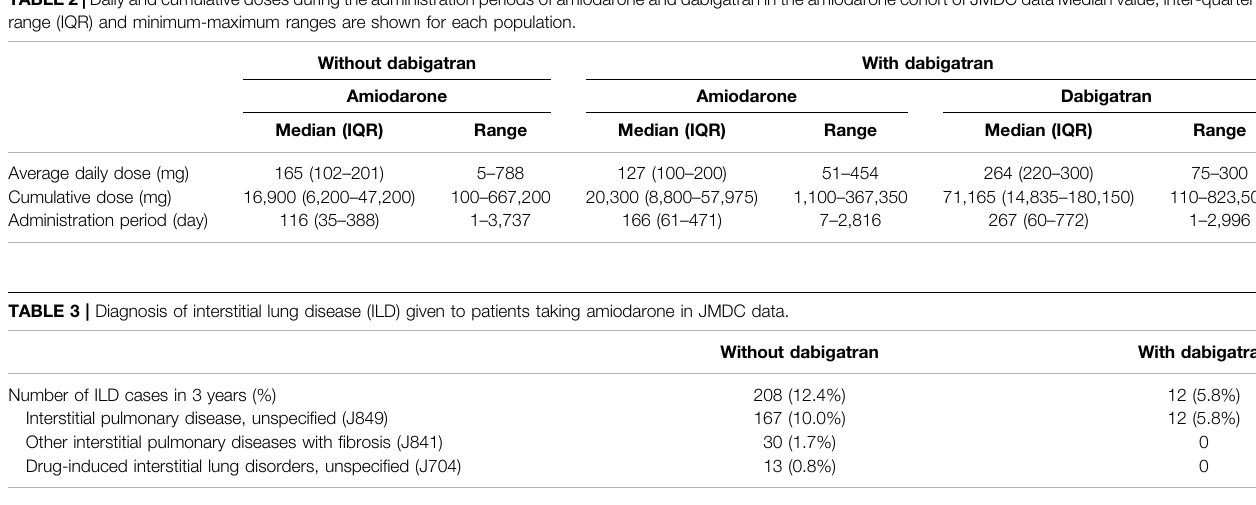
TABLE 2 | Daily and cumulative doses during the administration periods of amiodarone and dabigatran in the amiodarone cohort of JMDC data Median value, inter-quarter range (IQR) and minimum-maximum ranges are shown for each population.